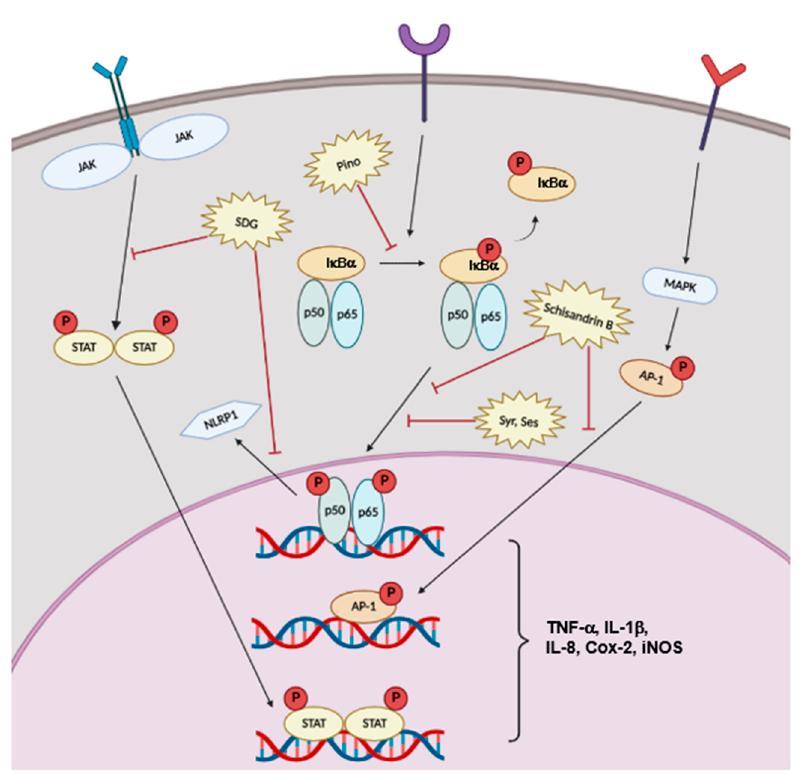
Figure 4. Anti-inflammatory properties of lignans. Various lignans block the expression of pro- inflammatory cytokines via downregulating JAK/STAT, NF- κ B, and AP-1 pathways. inflammatory cytokines via downregulating JAK/STAT, NF- κ B, and AP-1